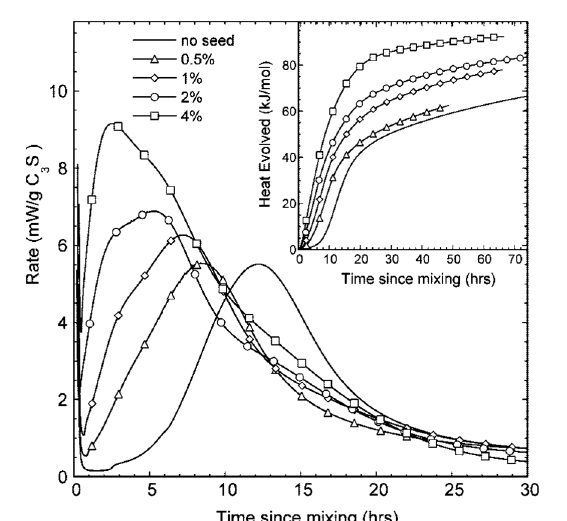
Figure 8. Effect of C ‐ S ‐ H seed made with a molar ratio Ca/Si of 1 on the early hydration kinetics of C 3 S hydration. The seed amounts refer to the mass of solid C ‐ S ‐ H per mass of C 3 S. Reproduced with permission from [89]. For special applications like classical wet shotcrete, bi